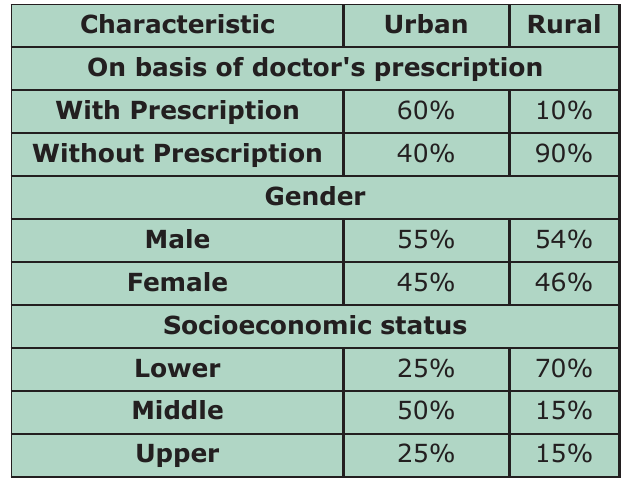
Table-II: Reported percentage of patients coming to Pharmacies.